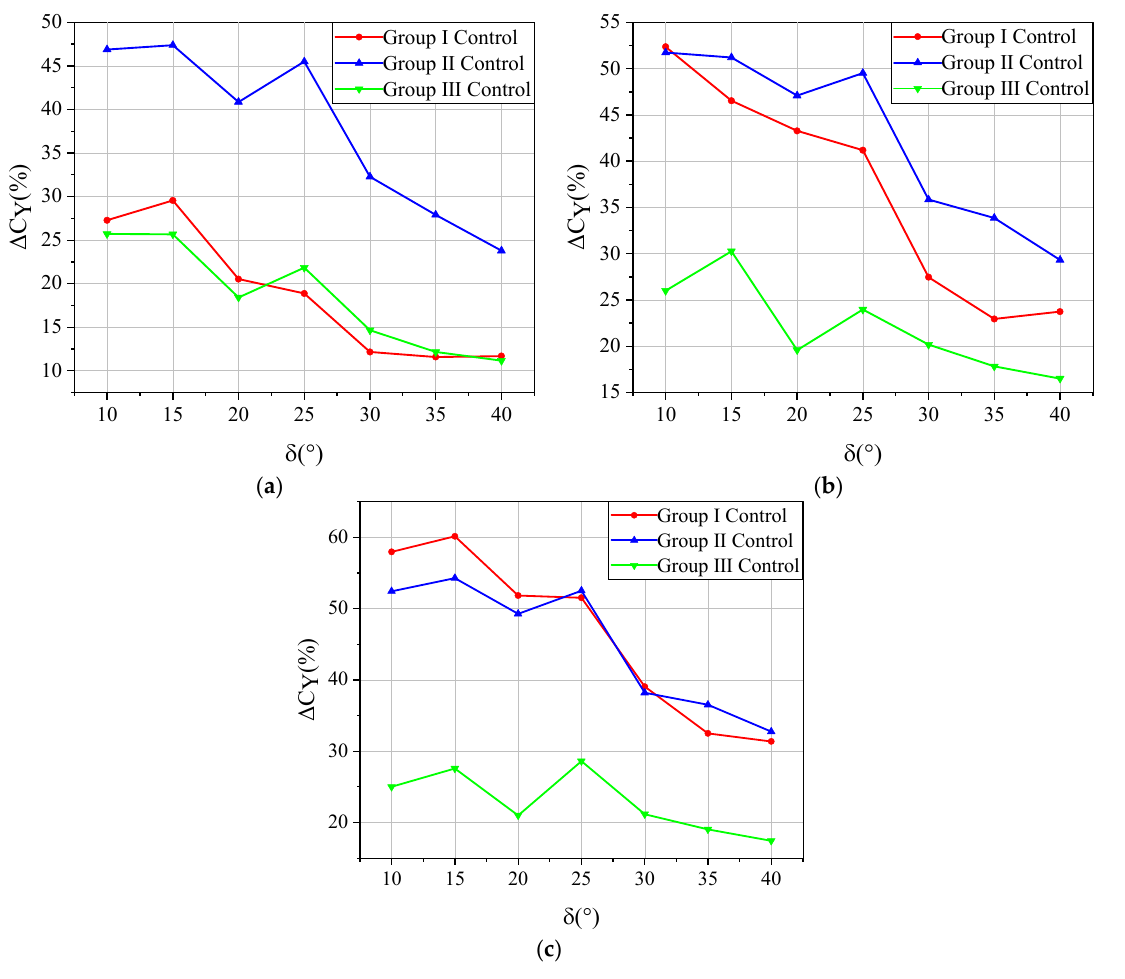
Figure 17. Vertical tail model lateral force coefficient increment curves under different control positions: ( a ) C μ = 0.083%; ( b ) C μ = 0.166%; ( c ) C μ = 0.332% ( β = − 10°, Re = 2.12 × 10 5 ).